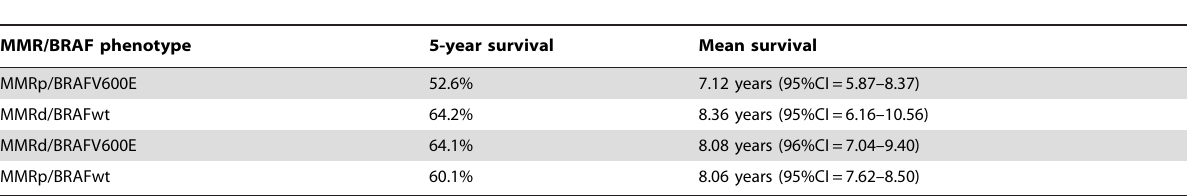
Table 2. Overall survivals of each of the four MMR/BRAF phenotypes by Kaplan Meier actuarial